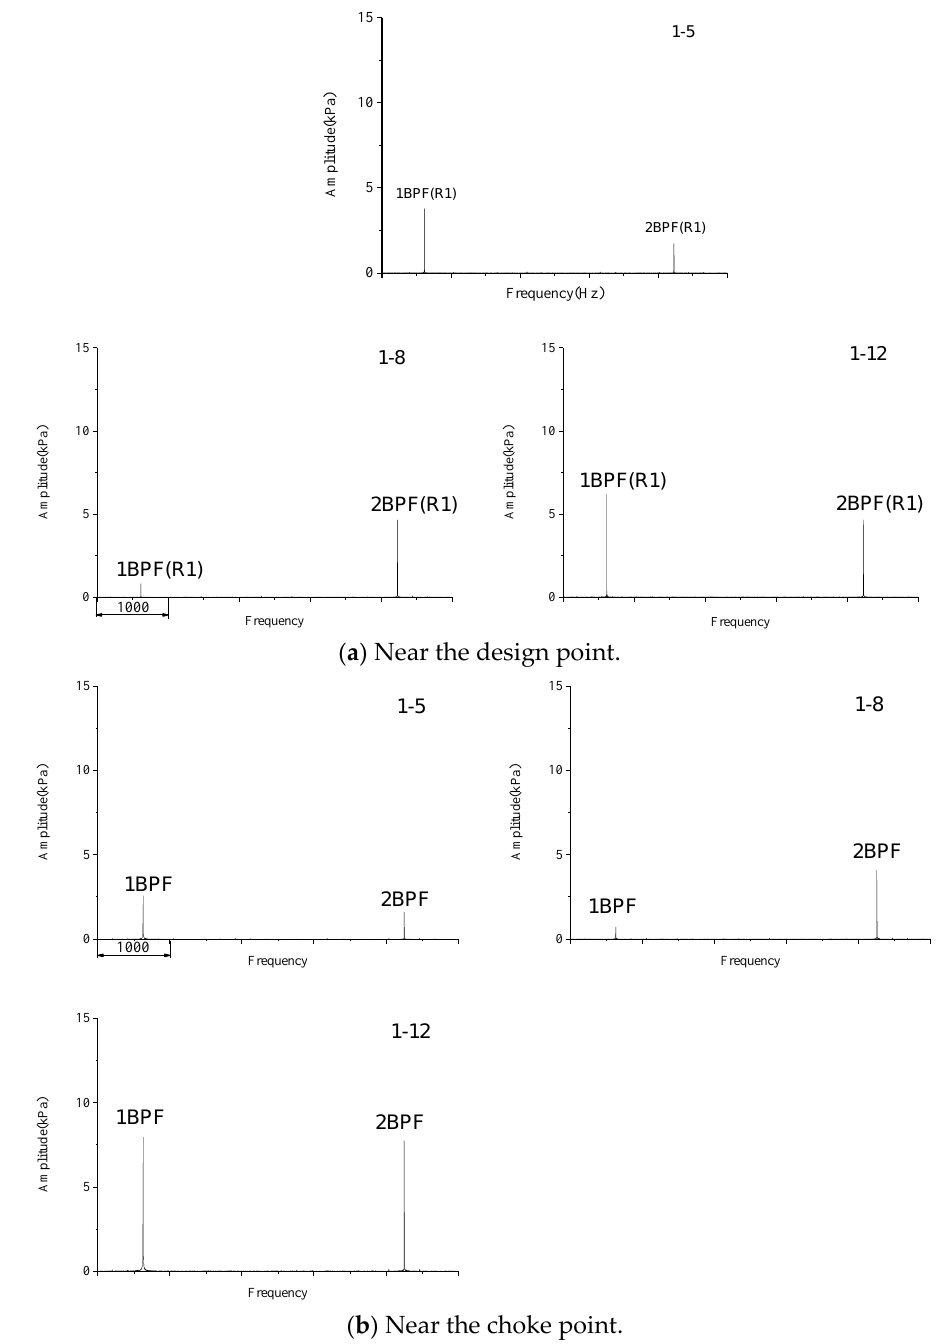
Figure 21. The comparison of the pressure frequency spectrums between the near choke and design conditions inside R1 .